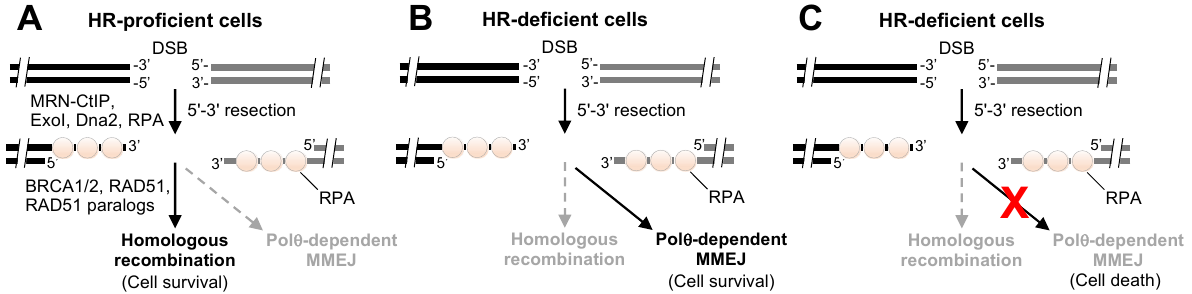
Figure 2. Model of Pol θ dependency in HR-deficient cells. ( A ) DSBs are predominantly repaired in S/G2 cell cycle phases by accurate HR, which is promoted by BRCA1/2, RAD51, and associated proteins. Pol θ -dependent MMEJ serves as a backup DSB repair pathway that acts on 3 ′ ssDNA overhangs and causes large indels. ( B ) HR-deficient cells rely on Pol θ -dependent MMEJ for DSB repair and cell survival. ( C ) Inactivation or suppression of Pol θ causes synthetic lethality in HR-deficient cells as a result of insufficient DNA repair.